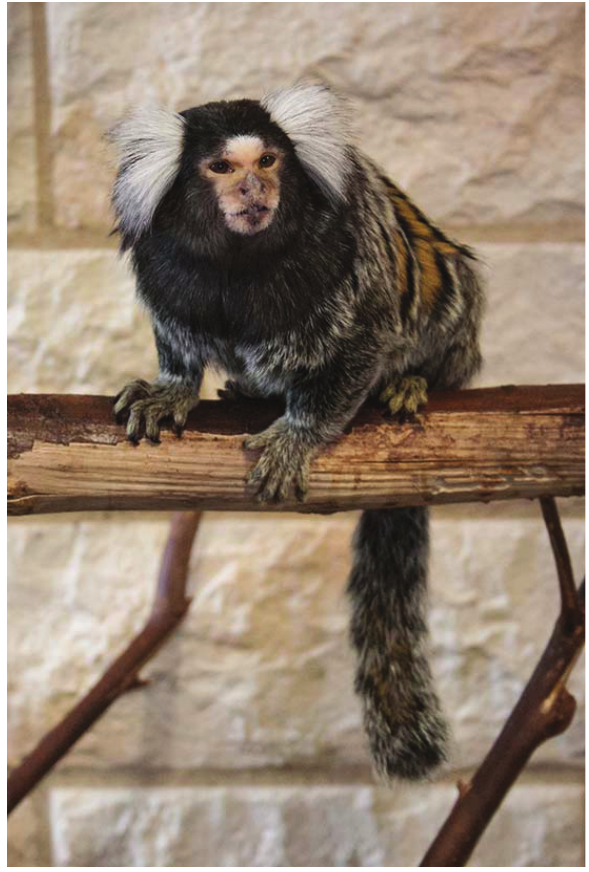
Figure 1. Common marmosets ( Callithrix jacchus ) are small non-human primates with a body weight of 350–450 g. Adult marmoset at the facilities of the German Primate